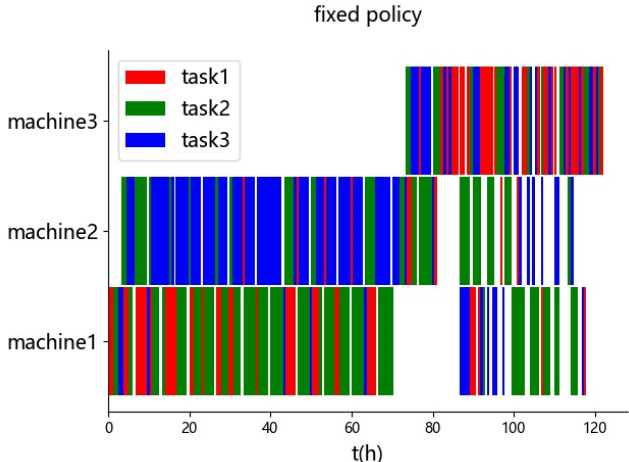
Figure 7. Gantt chart of fixed strategy scheduling method.